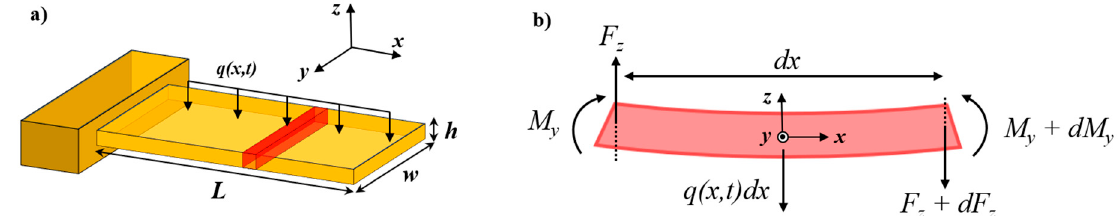
Figure 1. ( a ) Schematic of a cantilever beam of length L , width w , and thickness h . The cantilever is subjected to a distributed time-changing load per unit length, q ( x , t ); ( b ) longitudinal cross section of an infinitesimal element dx of the same cantilever (red part highlighted in ( a )), where the shear forces and bending moments act.